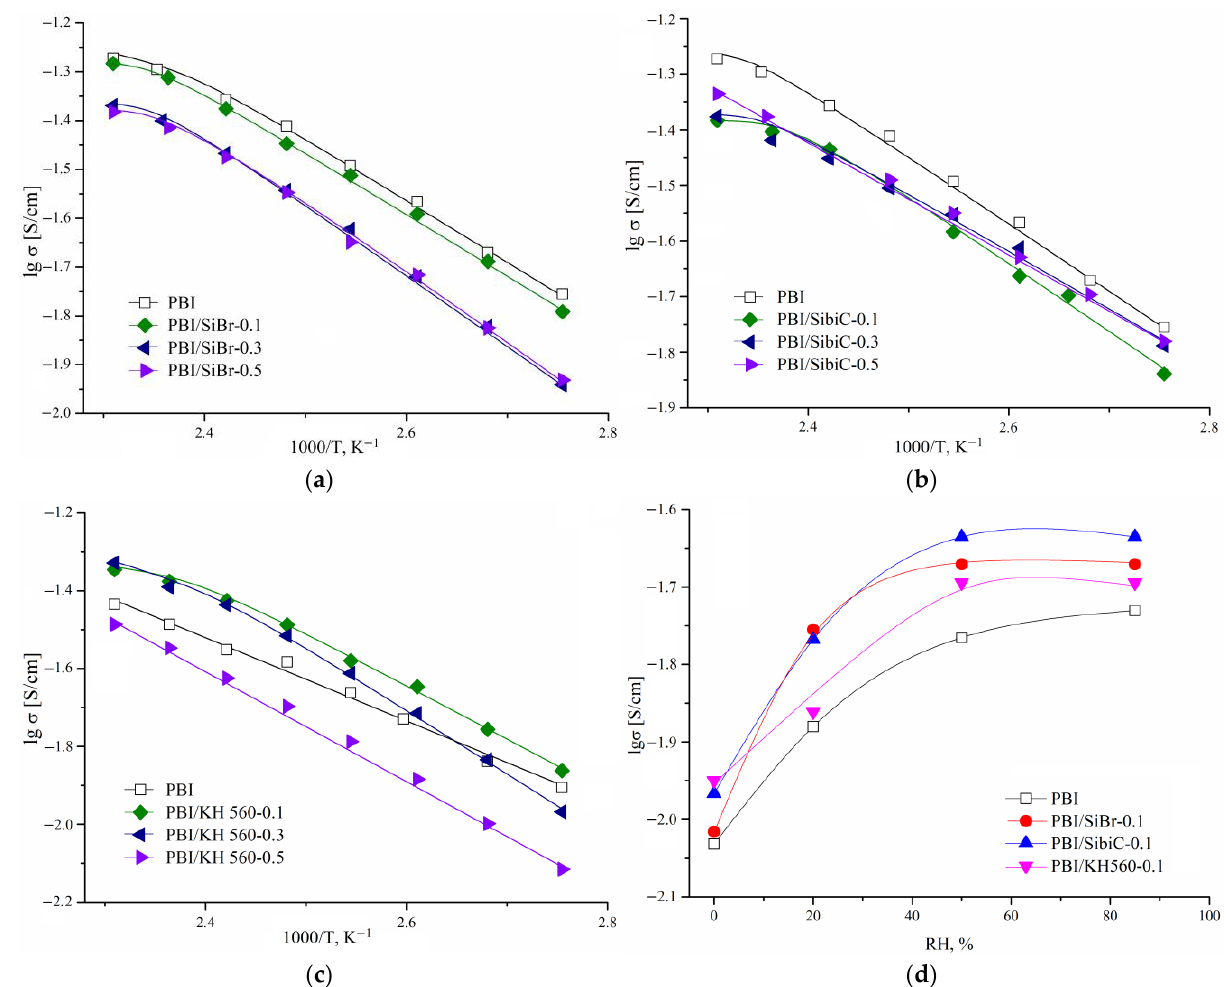
Figure 7. Dependence of conductivity on temperature ( a – c ) and relative humidity; ( d ) for PBI membranes crosslinked with silanes of different structure.